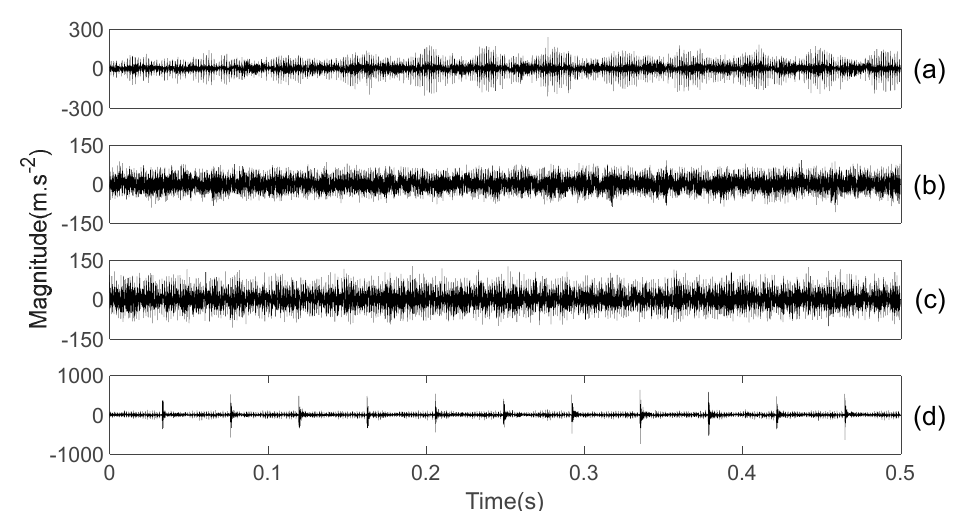
Figure 3. Four types of gear vibration data, where ( a – d ) are for normal, slightly worn, medium-worn, and broken-tooth conditions, respectively.